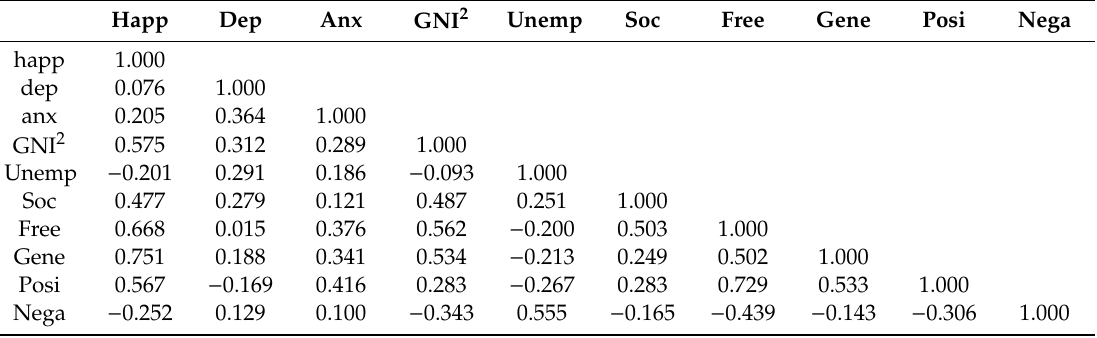
Table A2. The correlation matrix among variables in high-income countries.